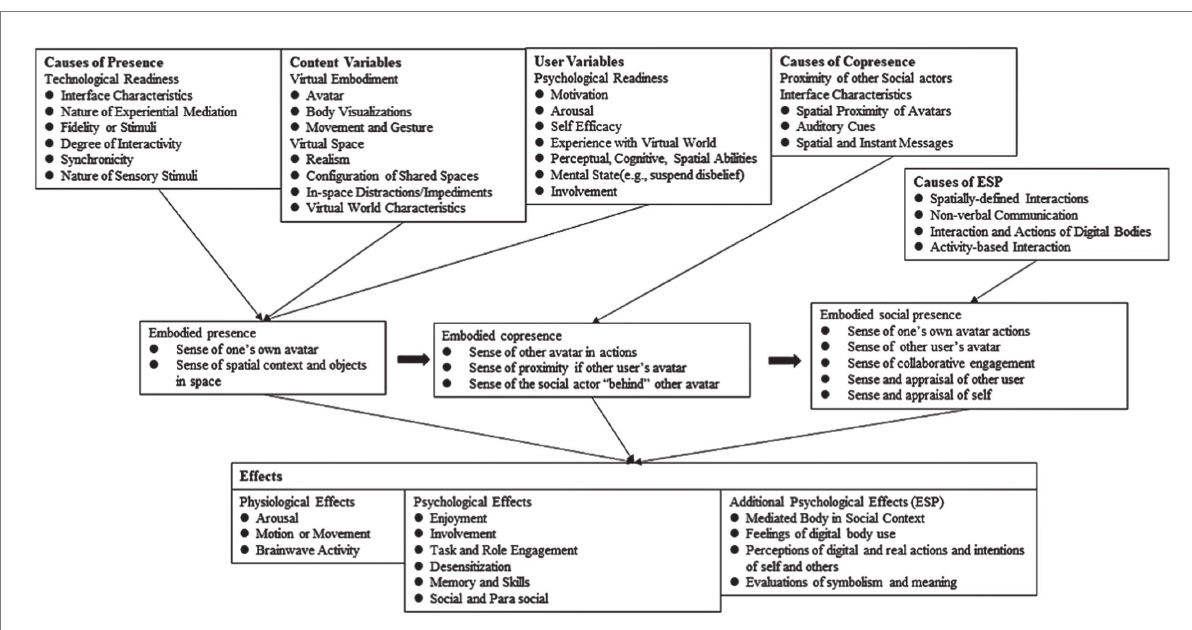
FIGURE 1 Metaverse Google trends.